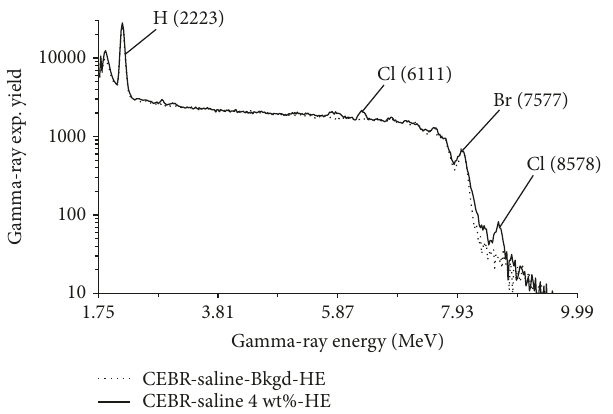
Figure 8: High-energy pulse height spectrum of the CeBr for a saline water sample over 1.75 – 9.98MeV range from a 4% chlorine-contaminated water sample superimposed upon background spectrum.